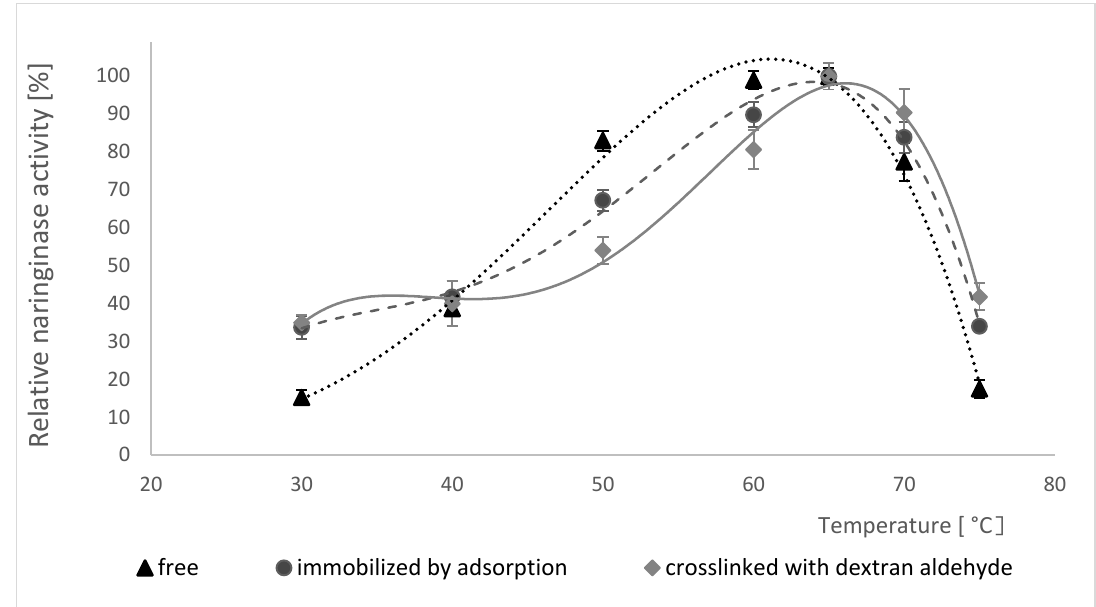
Figure 5. Influence of temperature on activity of free, adsorption-immobilized and crosslinked naringinase from A. niger KMS. Activity of free naringinase (100% = 952 µmol min −1 g −1 of the preparation); Activity of immobilized naringinase by adsorption (100% = 24.81 µmol min −1 g −1 of the carrier); Activity of crosslinked naringinase with dextran aldehyde (100% = 28.25 µmol min −1 g −1 of the carrier). The optimum temperature of enzymes was determined at various temperatures (from 30 to 80 °C) at pH 4.0.